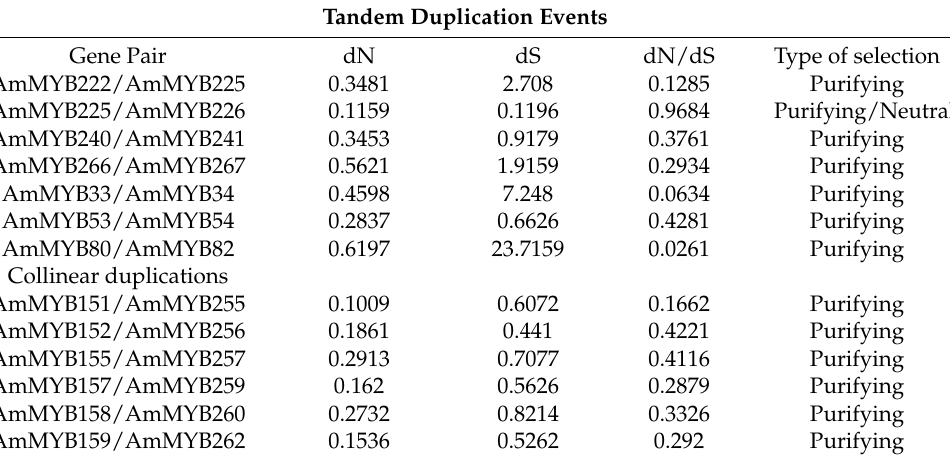
Figure 2. Chromosomal location and duplication events of AmR2R3 MYB . The AmR2R3 MYB genes were distributed on 22 pseudo-chromosomes of A. marina based on their physical positions. The tandemly duplicated genes are indicated with blue arrows. The red dashed lines between pseudo-chromosomes 18 and 30 indicate the collinear genes. Table 2. The ratio of non-synonymous to synonymous substitution rates (dN/dS) in the AmR2R3 MYB